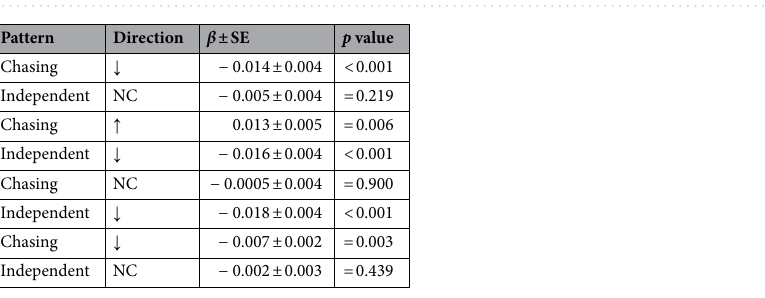
Table 2. Within-trial dynamics of looking at each pattern within Trial 1 and 2 (linear regression). In case of direction, ↓ indicates reducing and ↑ increasing visual attention, NC indicates no change.